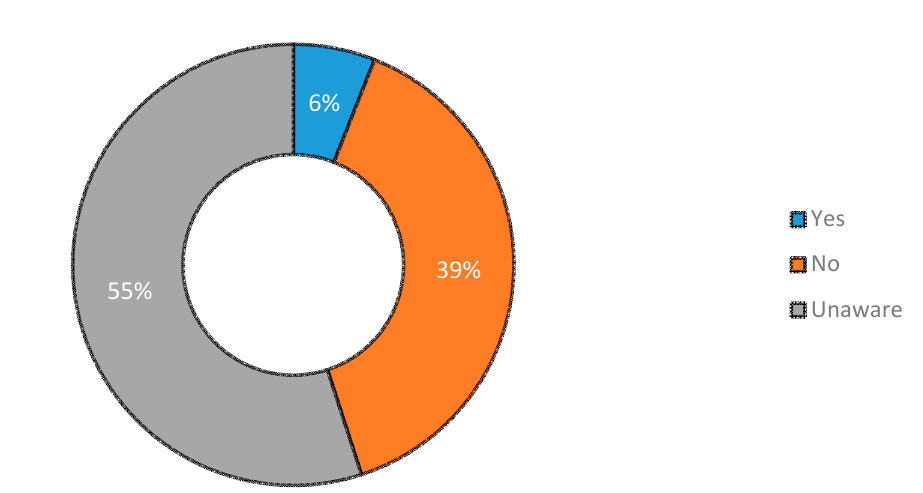
Figure 5. Are NCBs synonymous to biosimilar drugs according to Industry Experts.